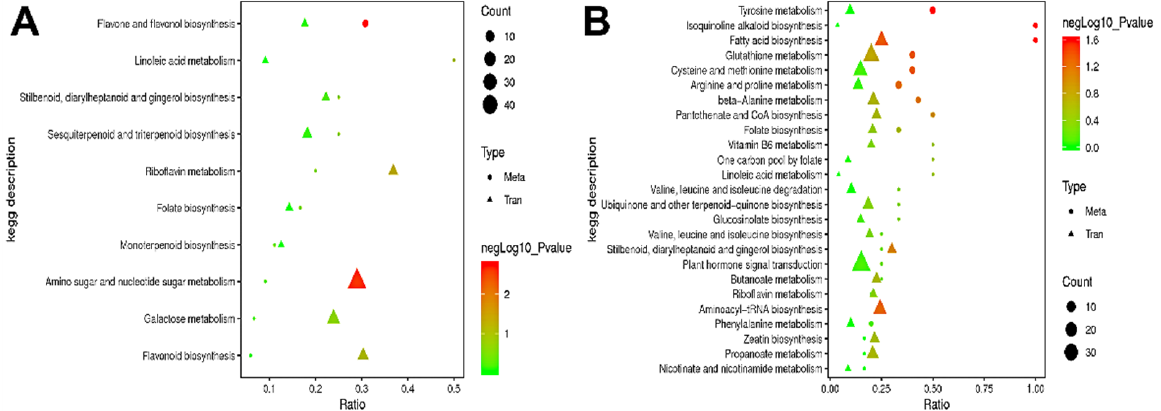
Figure 10. Association analysis of differential genes and KEGG pathways. Annotation: ( A ) A2 compared to A1; ( B ) B2 compared to B1. The abscissa is the ratio of the number of different metabolites or genes enriched in the pathway to the number of metab-olites or genes annotated in the pathway, and the ordinate is the KEGG pathway co-enriched by metabolomics and transcriptomics. Count: the number of metabolites or genes enriched in the pathway.